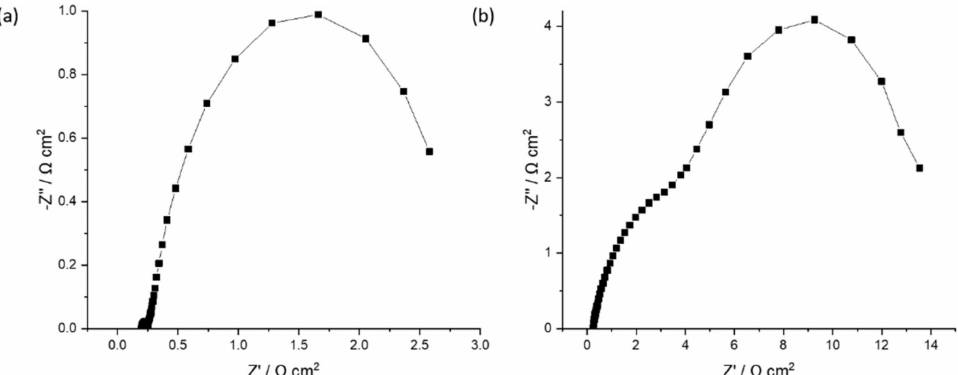
Figure 9. Nyquist plot for a potential of 1.445 V (activation phase) for the ( a ) Pt/CB and ( b ) 50% FeP/CB